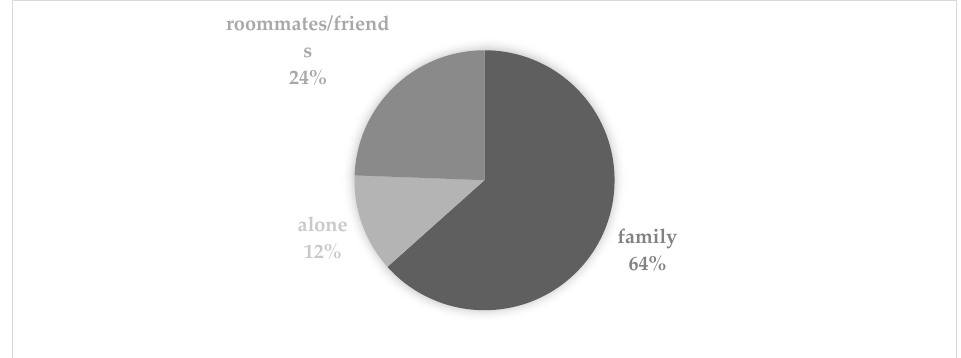
Figure 1. Description of the sample regarding with whom the lockdown was spent.